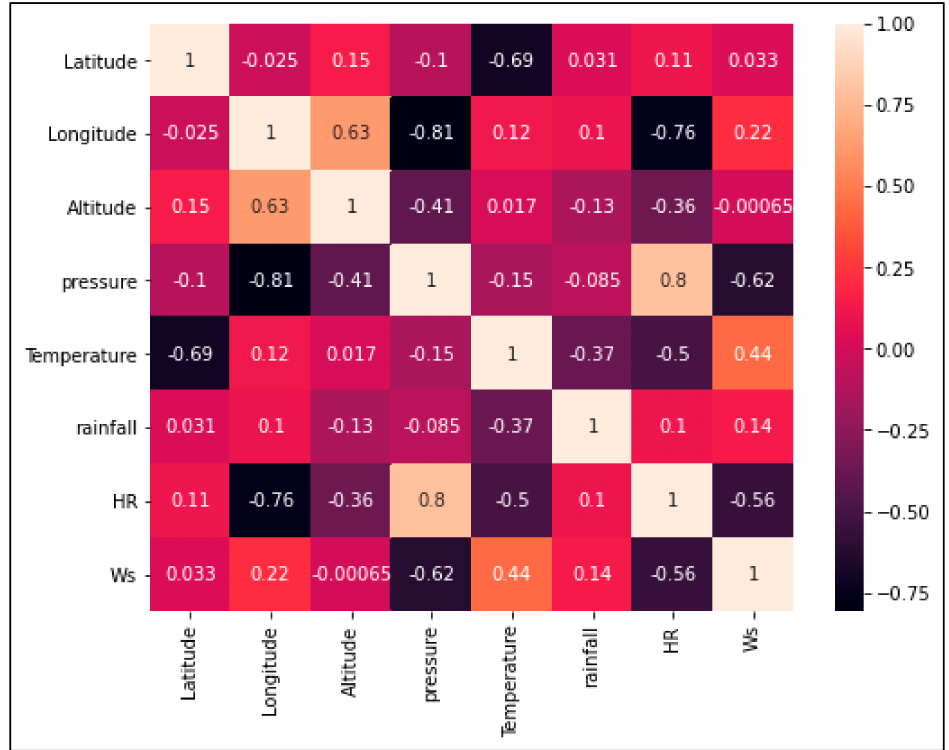
Figure 5. Correlation matrix of Hurst exponents for the time series made up of days with Santa Ana winds.